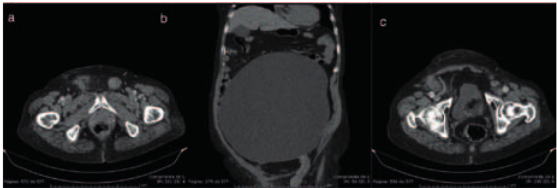
Figure 1. Haematoxylin and eosin (H & E) staining, at 20x magnifi - cation, of Sertoli-Leydigtumor with tubular pattern, with the two types of cells and hyalinized fi brous stroma